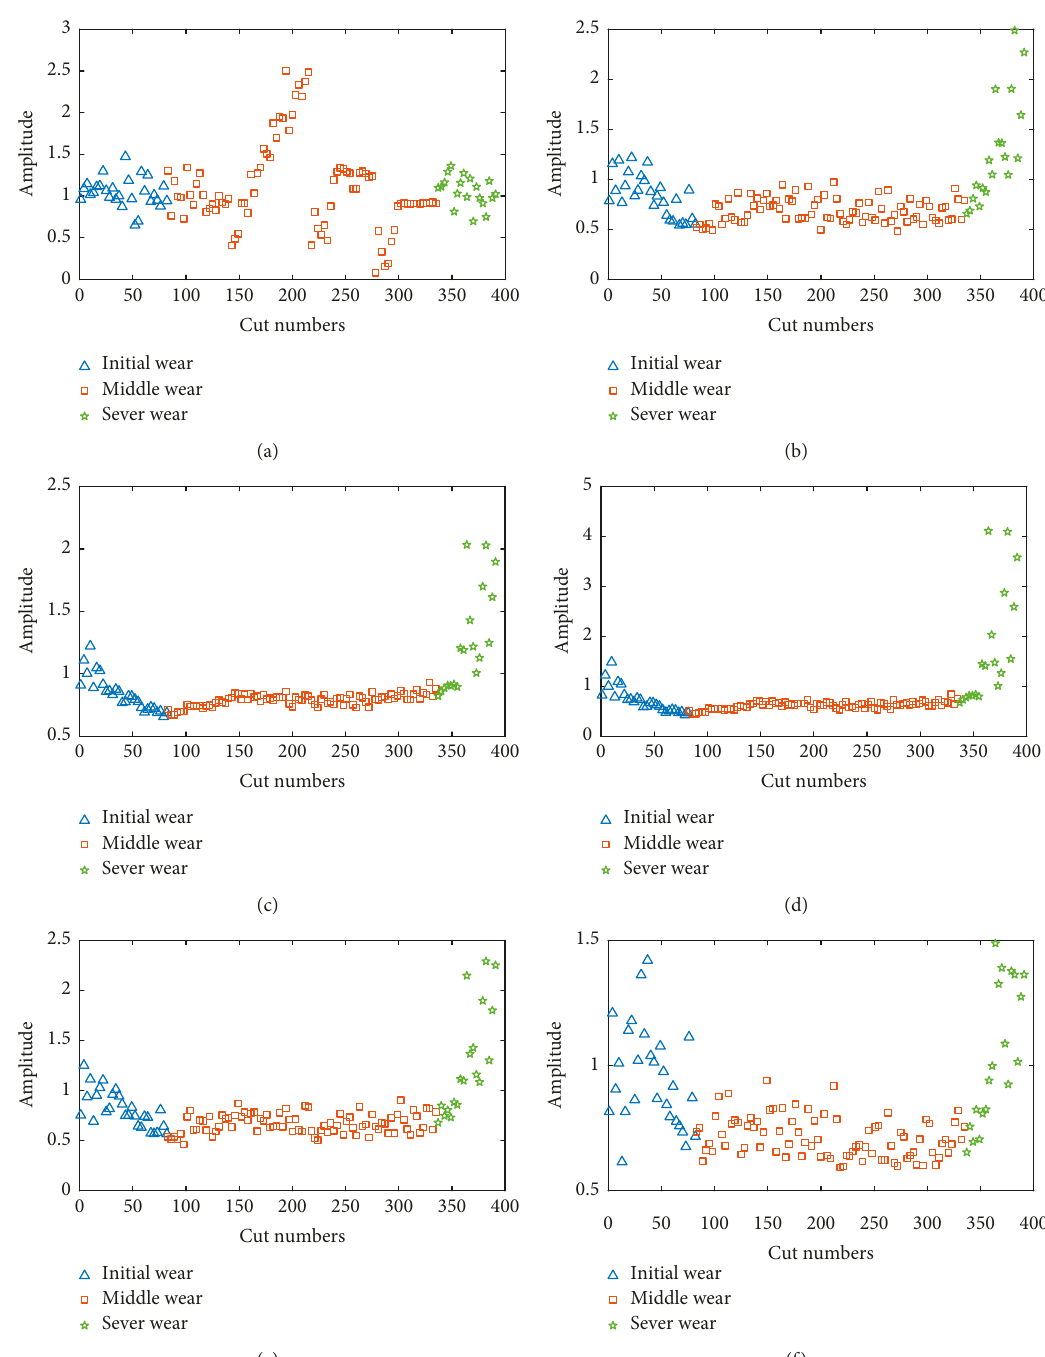
Figure 7: X -directional vibration signal feature extraction in time domain: (a) mean, (b) peak, (c) RMS, (d) variance, (e) kurtosis, and (f)